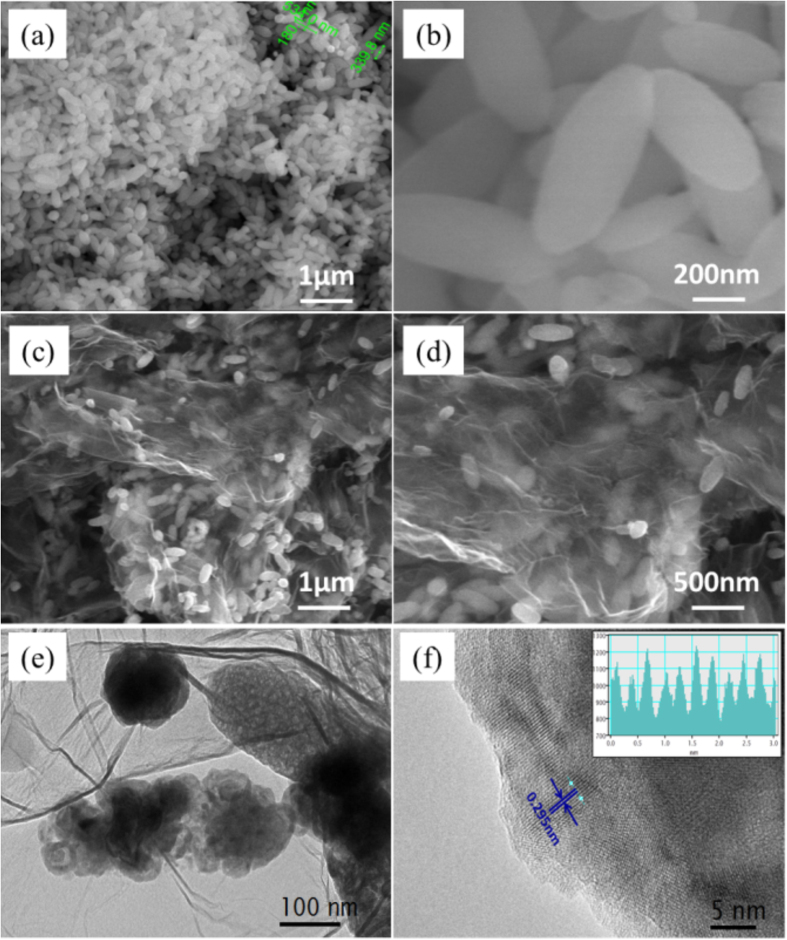
Typical SEM images of CoxFe2-xO3 (a,b) and CoFe@rGO (c,d). Typical TEM images of CoFe@rGO (e,f).